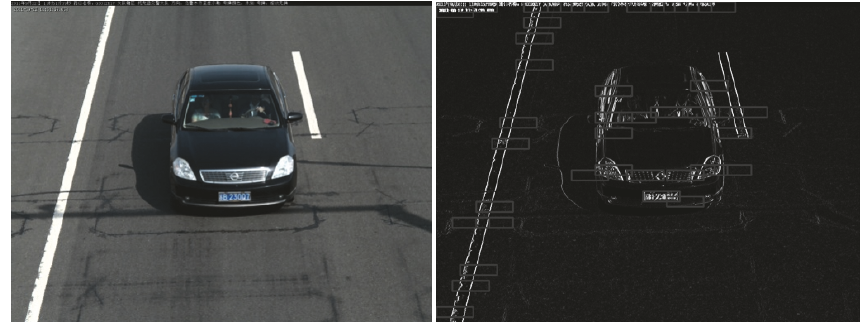
Figure 2: Candidate regions obtained by the shallow